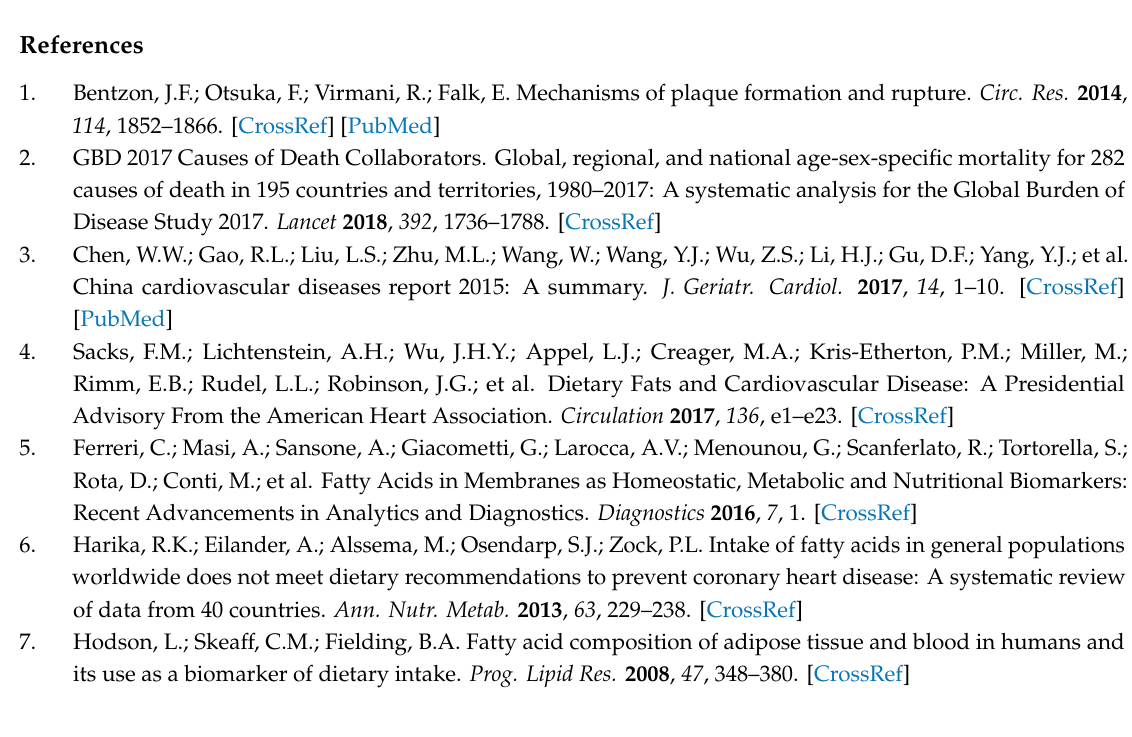
proportions. Table S5. Hazards ratios (95% confidence interval) for carotid artery plaques according to quartiles of the erythrocyte VLCSFA proportions stratified by gender. Table S6. Characteristics of the eligible